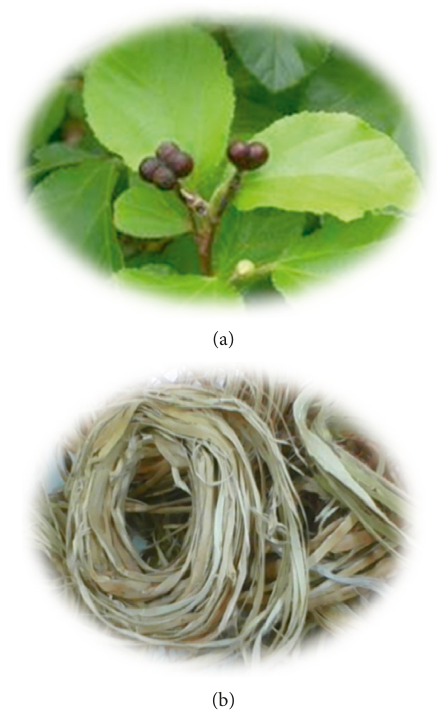
Figure 1: Grewia spp. leaves (a) and barks